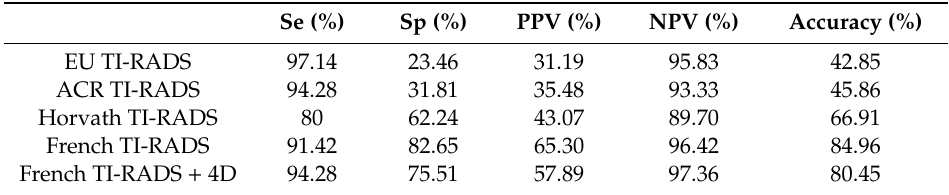
Table 6. Compared Diagnostic Quality: sensitivity (Se), specificity (Sp), positive predictive value (PPV), negative predictive value (NPV), and accuracy for the proposed TI-RADS